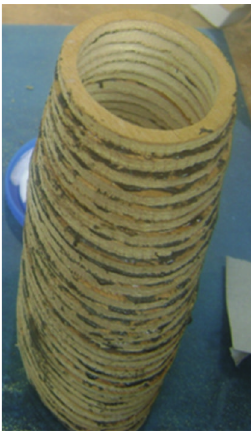
Figure 10: The rings were glued together to form the front part of the robot fish.